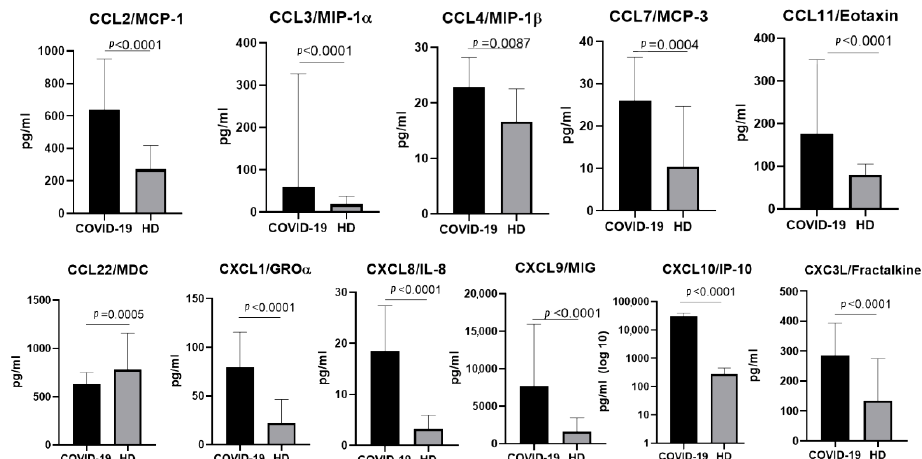
Figure 1. A comparison of the concentrations of the chemokines in the plasma of individuals infected with the original strain of SARS-CoV-2 in the acute stage (COVID-19), n = 56, and in healthy donors (HD), n = 51. The concentrations are presented in pg/mL plots representing medians with interquartile ranges. For CXCL10/IP-10, the Y -axis is presented as a logarithmic scale. Only chemokines with a statistically significant difference are presented.